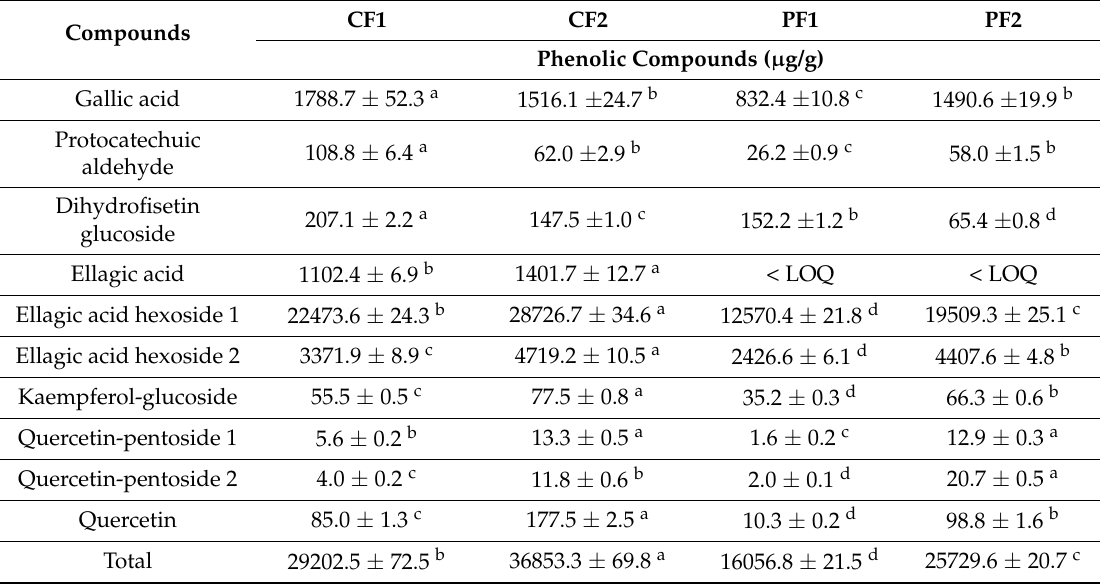
Table 4. Concentrations ( µ g/g) of phenolic compounds in grape seeds enriched extracts from cv. Chardonnay (C) and Pignoletto (P)